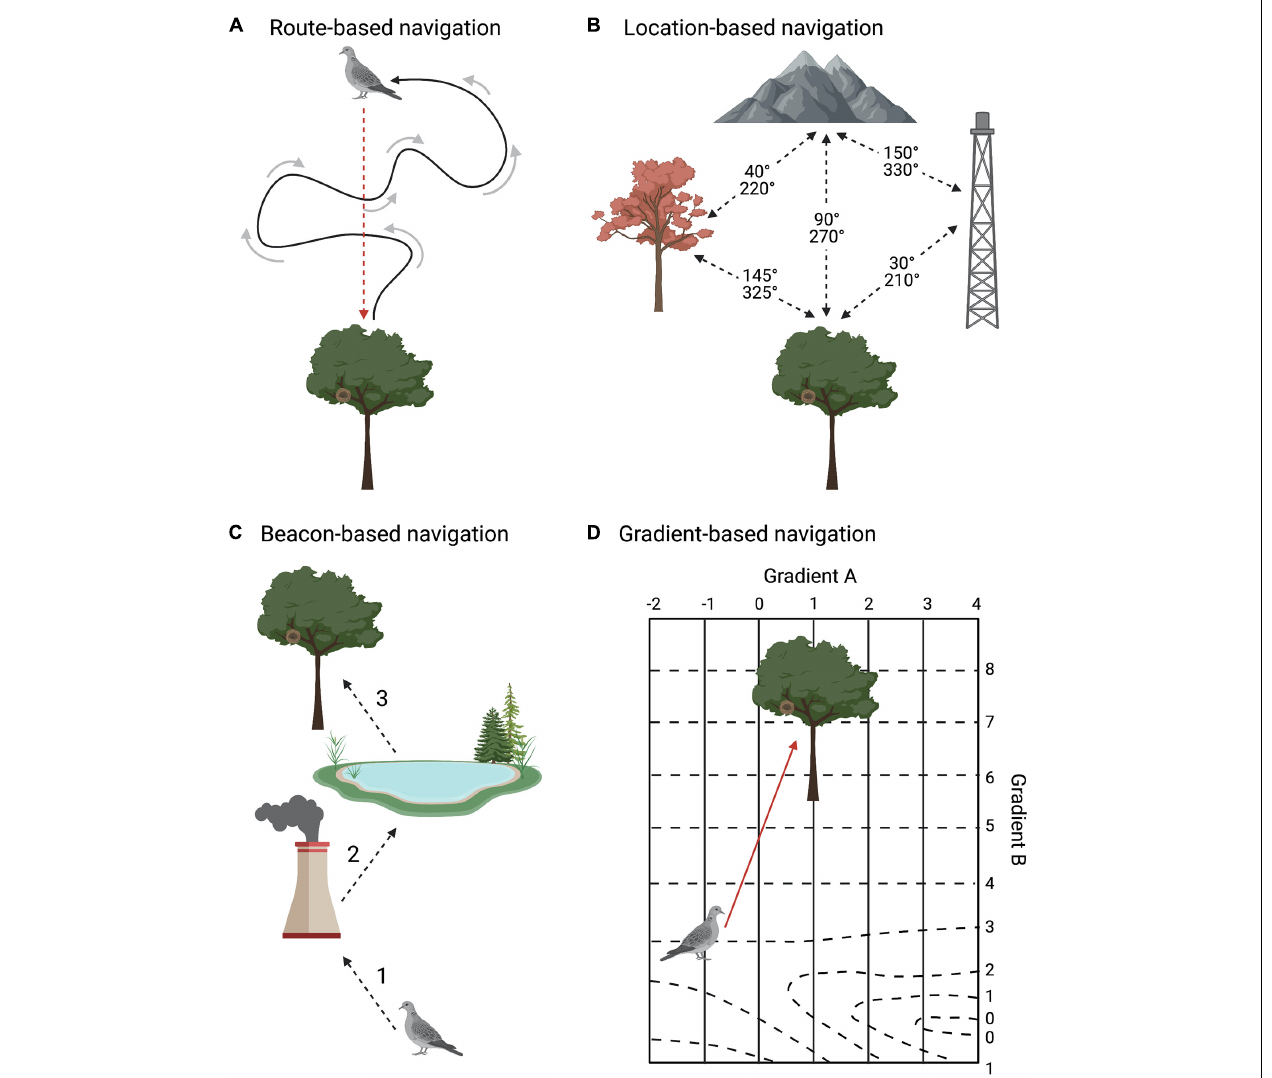
FIGURE 4 | Types of memory-based navigation. (A) In route-based navigation, the individual sums the distance and direction of its outward movements to estimate its current position and take a direct path to its starting point. (B) In location-based navigation, the individual memorizes spatial relationships between landmarks and goals. (C) In beacon-based navigation, specifically pilotage, the individual follows sequential landmarks leading to the goal. (D) In gradient-based navigation, the individual navigates with memorized gradients. In this illustration, both gradients are magnetic (solid and dash lines), with a magnetic anomaly in the southeast corner, which could initially disorient the individual. The scale of D is over 1000 km. Created with